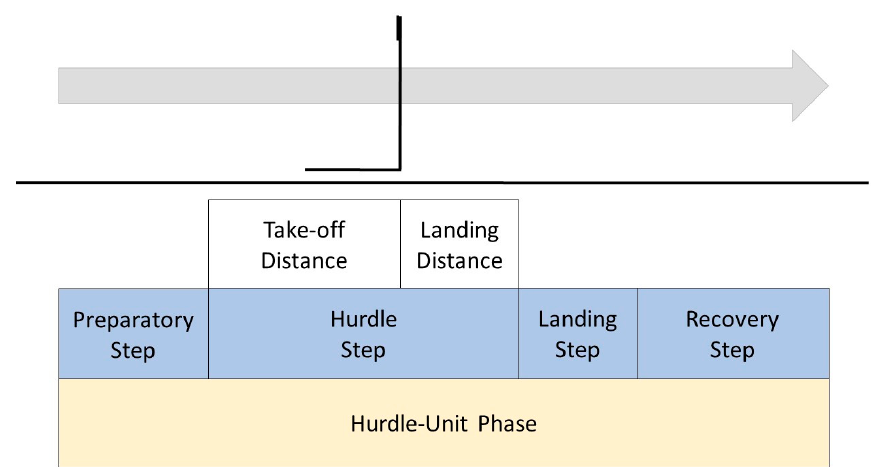
Figure 1. Definitions employed for the hurdle-unit phase analysis according to McDonald and Dapena [9].